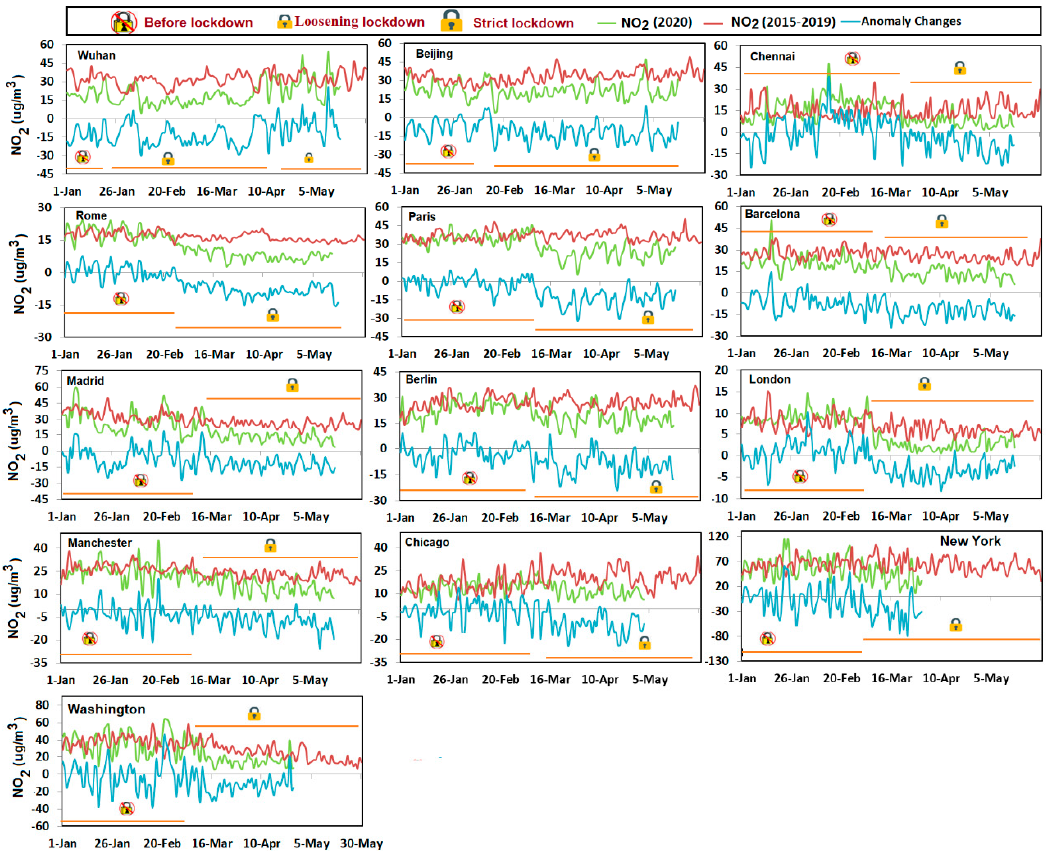
Figure 7. Daily mean NO 2 dataset and its anomaly changes in di ff erent global metropolitan cities from January to May of 2020 against baseline value (average of 2015–2019 data). The bigger lock icon with a stop sign indicates the time before lockdown in 2020. The bigger lock icon indicates the period when lockdown is strictly enforced, and the smaller lock icon indicates the period when lockdown is still enforced but di ff erent stages of reopening already started. The light black line in the figure represents the zero line.